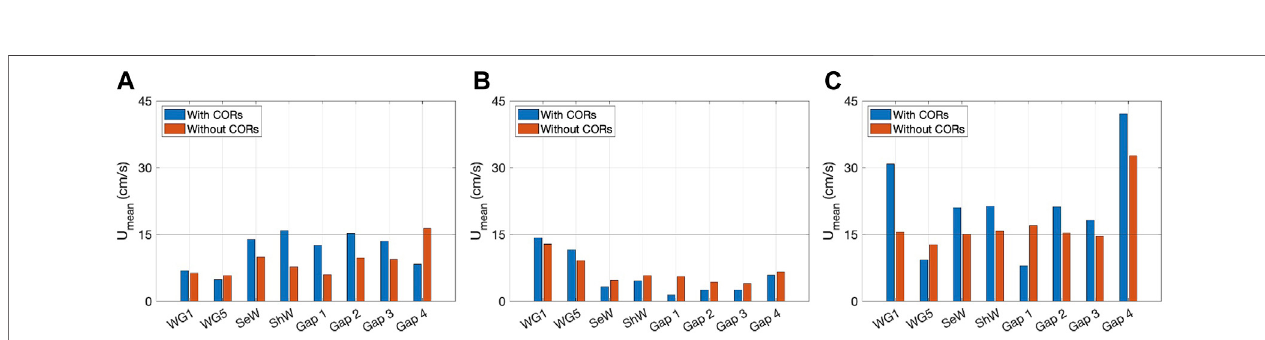
FIGURE 10 | Comparison of the wave-driven current velocity averaged for 20 min for (A) Case 1, (B) Case 2, and (C) Case 3 for two bathymetry con fi gurations.